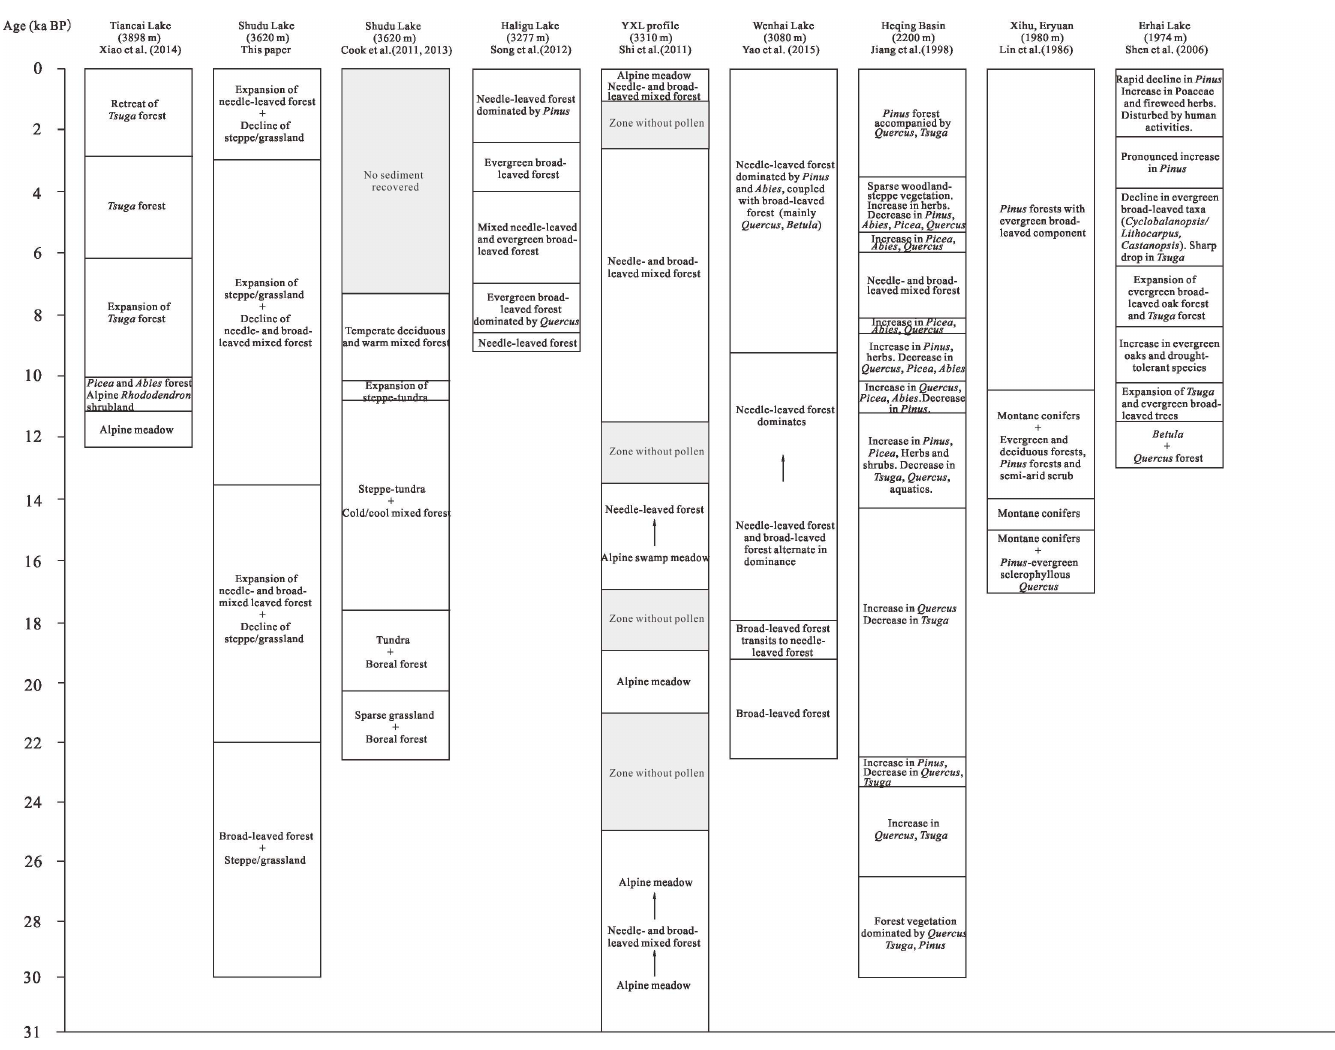
Fig 6. Regional comparison of vegetational succession in northwestern